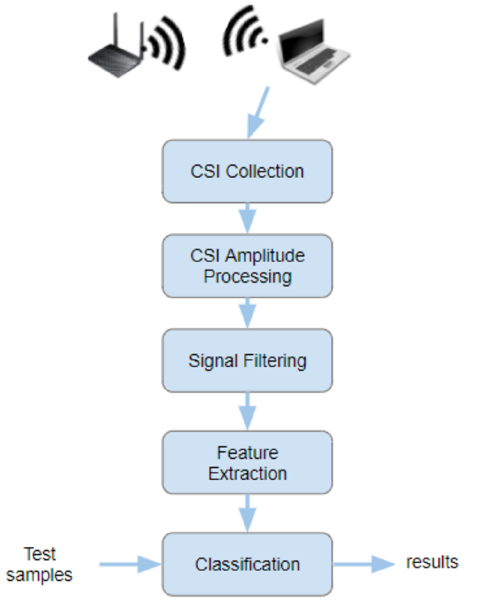
Figure 1. The proposed methodology with amplitude